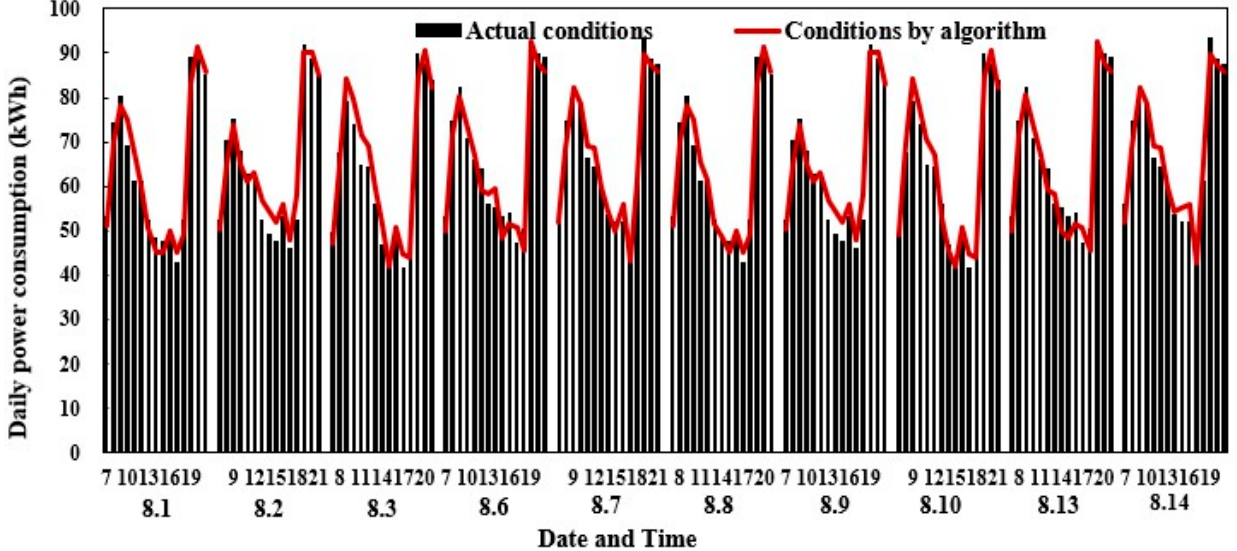
Figure 14. Comparison of separating the mixed data of the separation method and actual Figure 17. Comparison of separating the mixed data of the separation method and actual data.